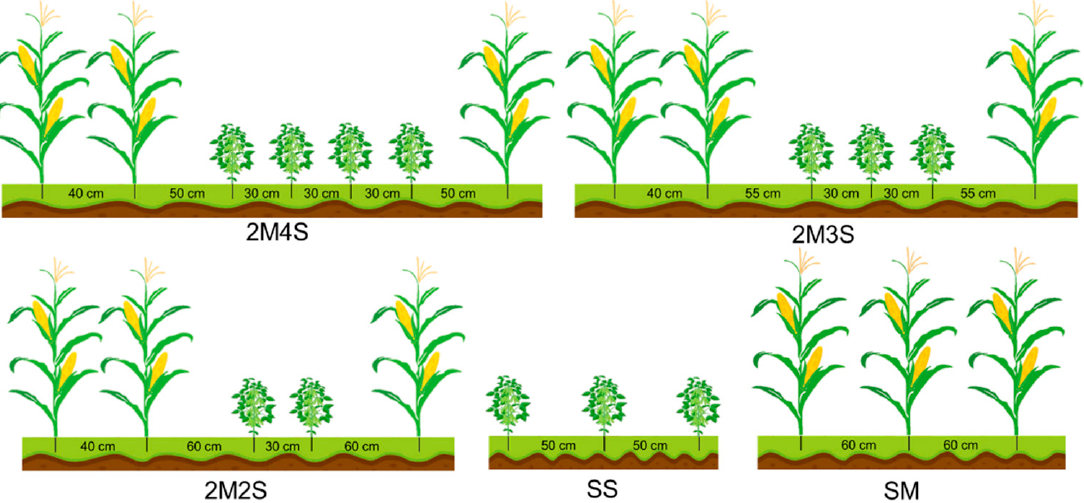
Figure 1. Different strip intercropping patterns of maize–soybean. Row spacings for soybean and maize rows in all strip intercropping planting patterns were 0.30 m and 0.40 m, respectively. The other spatial parameters were as follows: for 2M2S, the strip length was 1.90 m with 0.60 m distance between rows of maize and soybean, and the column spacing was 14.03 cm for maize and 7.01 cm for soybean; for 2M3S, the strip length was 2.10 m with 0.55 m distance between rows of maize and soybean, and the column spacing was 12.70 cm for maize and 9.52 cm for soybean; for 2M4S, the distance between the rows of soybean and maize was 0.50 m with a total strip length of 2.30 m, and the column spacing was 11.59 cm for maize and 11.59 cm for soybean; for SM, the distance between rows of sole cropping maize was 0.60 m, and the column spacing was 0.23 m; for SS, the distance between soybean rows was of 0.50 m, and the column spacing was 0.13 m.